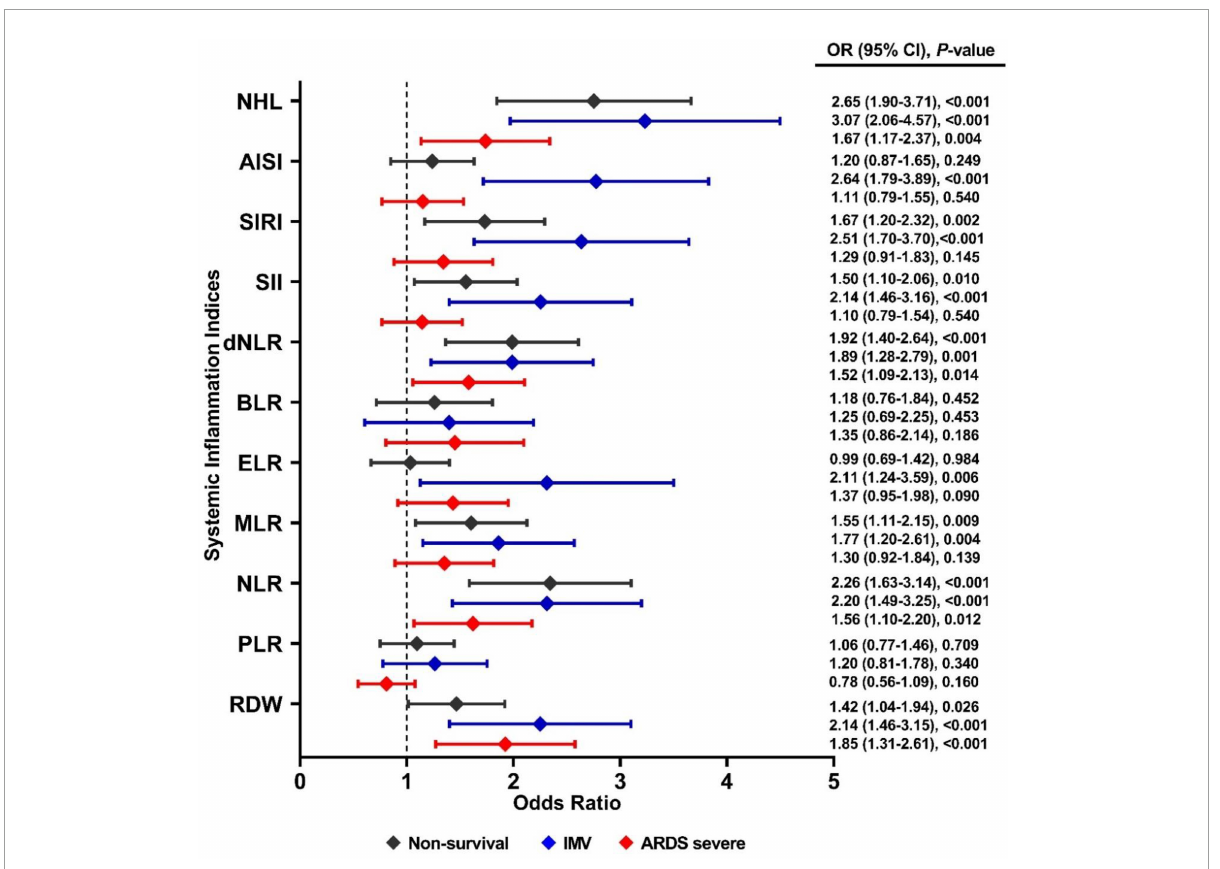
FIGURE2 Association between systemic inflammation indices and severe COVID-19, IMV support, and non-survival by COVID-19 in Mexican patients. Statistical analyses were performed by a multivariate logistic regression model adjusted by sex and age. Significance was set at p -value <